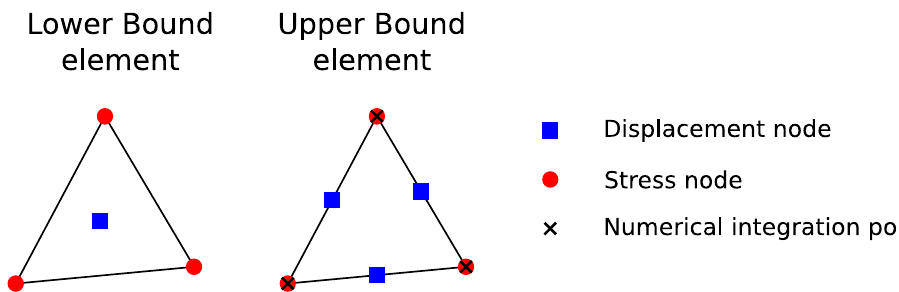
Figure 1. Triangular element of the finite element model. After [42].